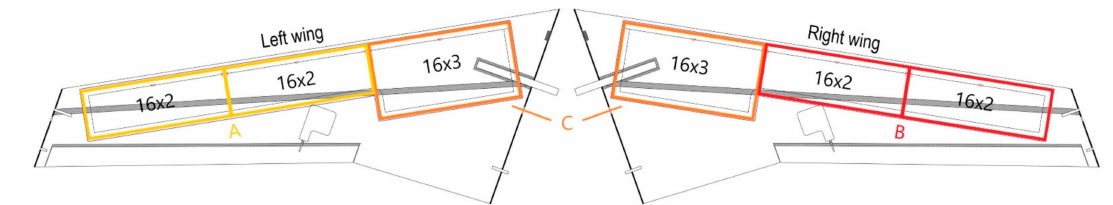
Figure 8. Shapes with the same color show pairs of series-connected solar modules (top